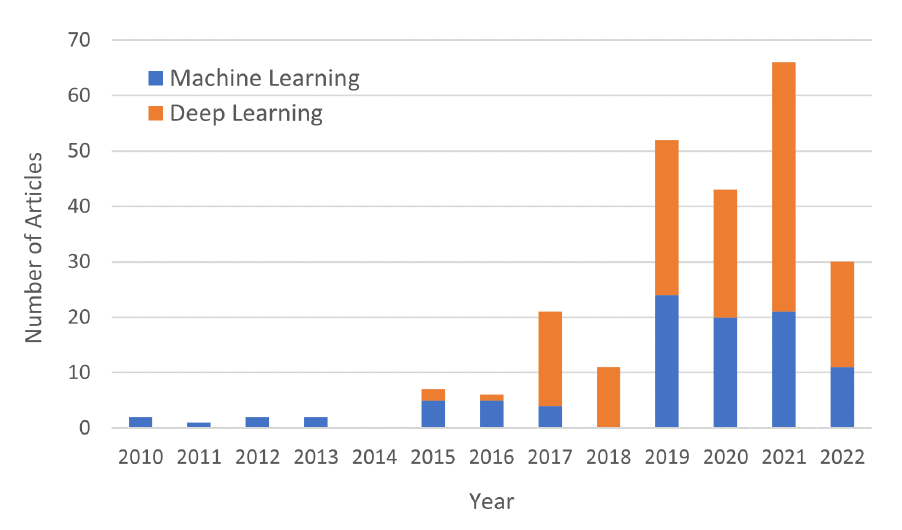
Figure 1. Evolution of the published articles based on deep learning or machine learning approaches found in the Scopus database for environmental and urban sound processing or classification between